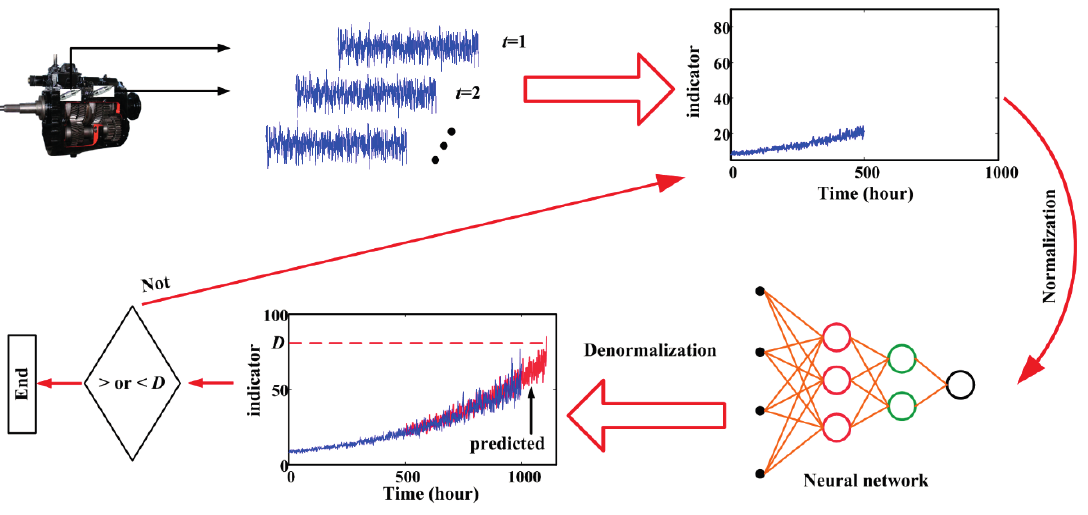
Figure 2. RUL estimation using rolling